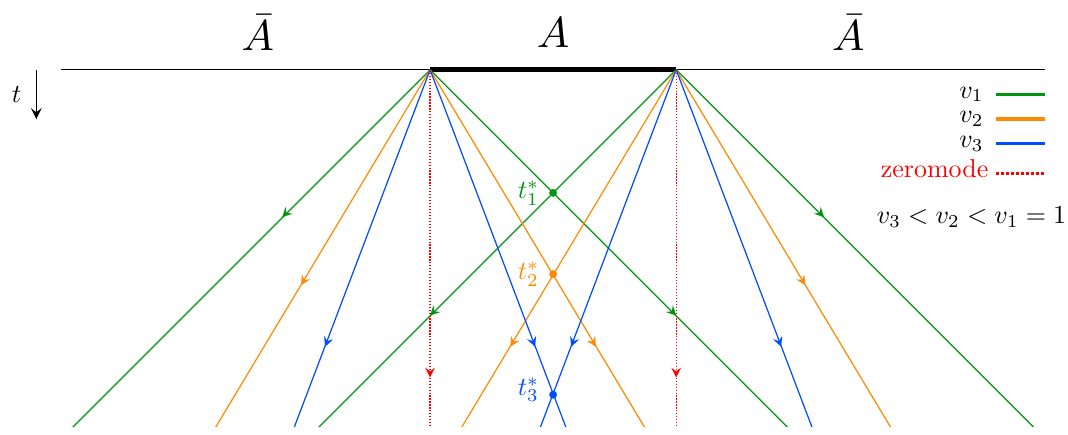
g . ; t (cid:3) ; t (cid:3) 1 2 3